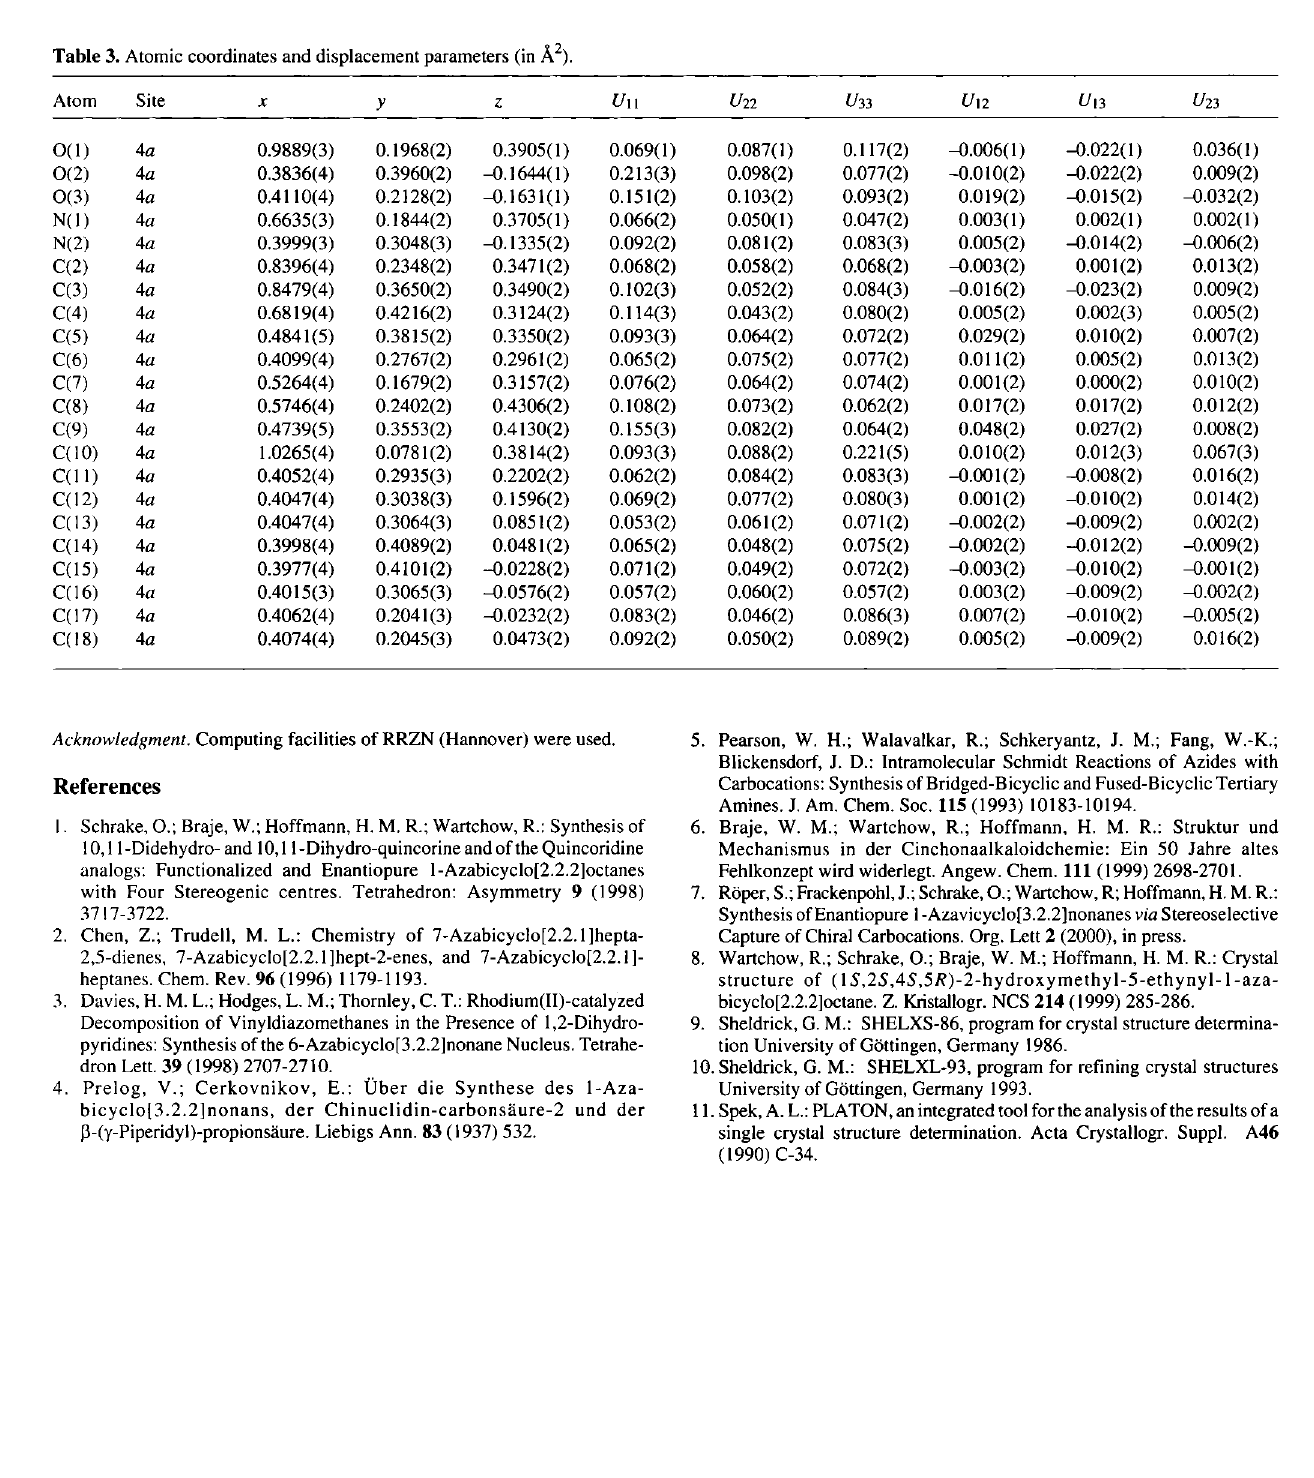
Table 3. Atomic coordinates and displacement parameters (in Ä 2